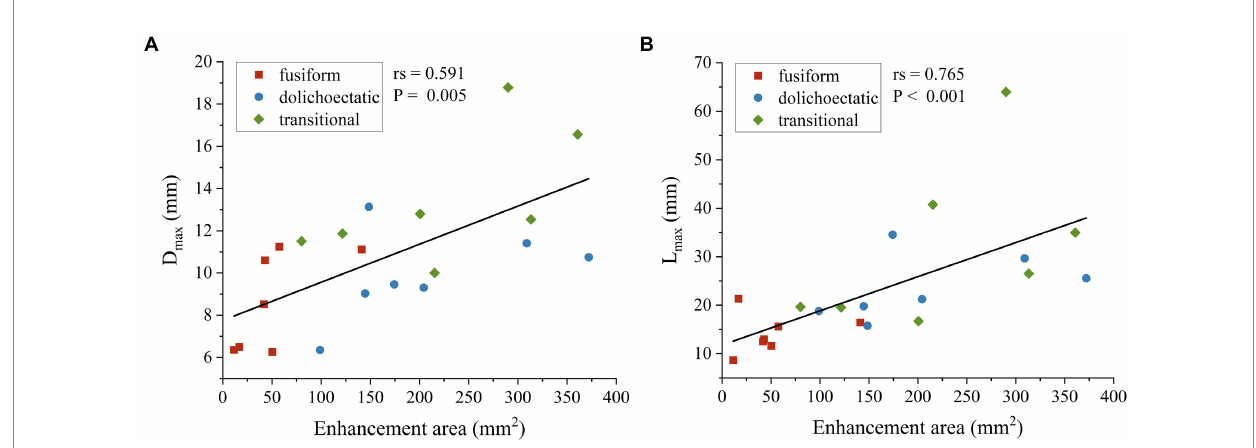
FIGURE 4 Scatter plots and spearman’s correlation analysis showed that enhancement area was positively correlated with D max (A) and L max (B) of intracranial fusiform